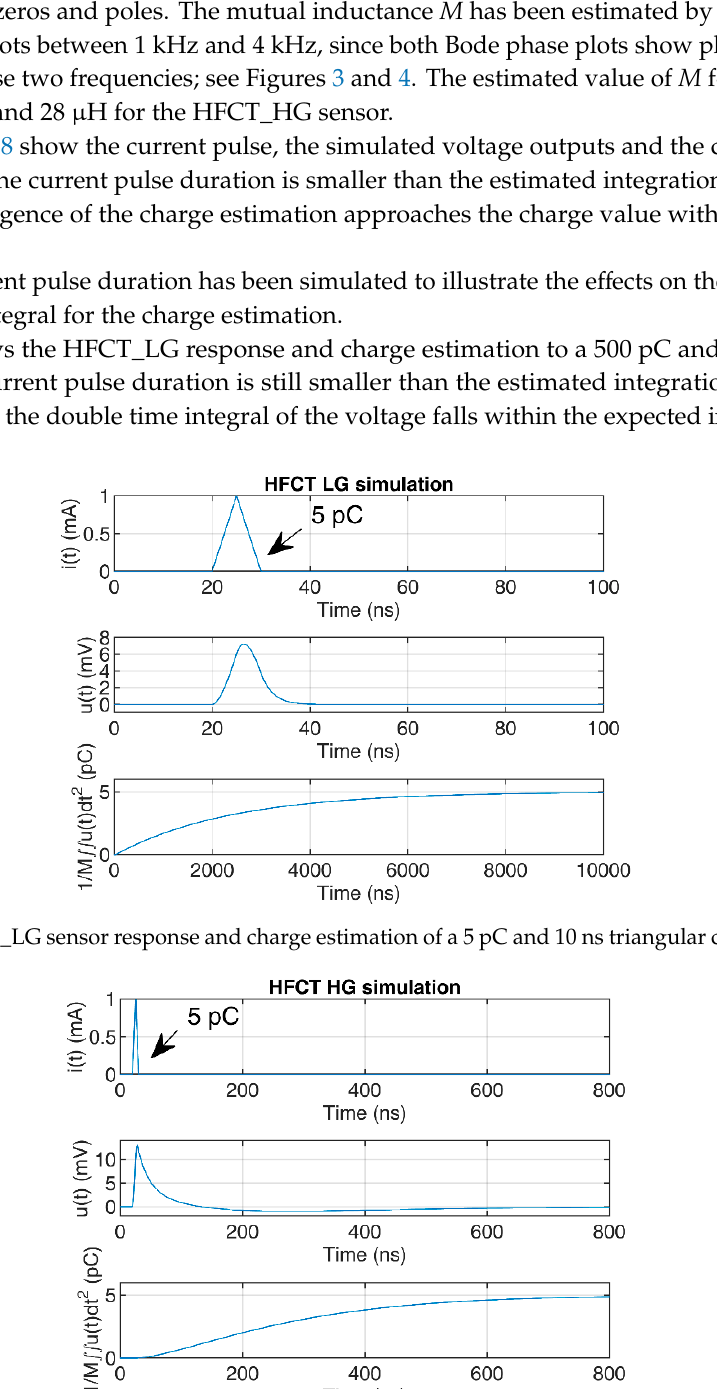
Figure 9. HFCT_LG sensor response and charge estimation of a 500 pC and 1000 ns triangular current pulse.